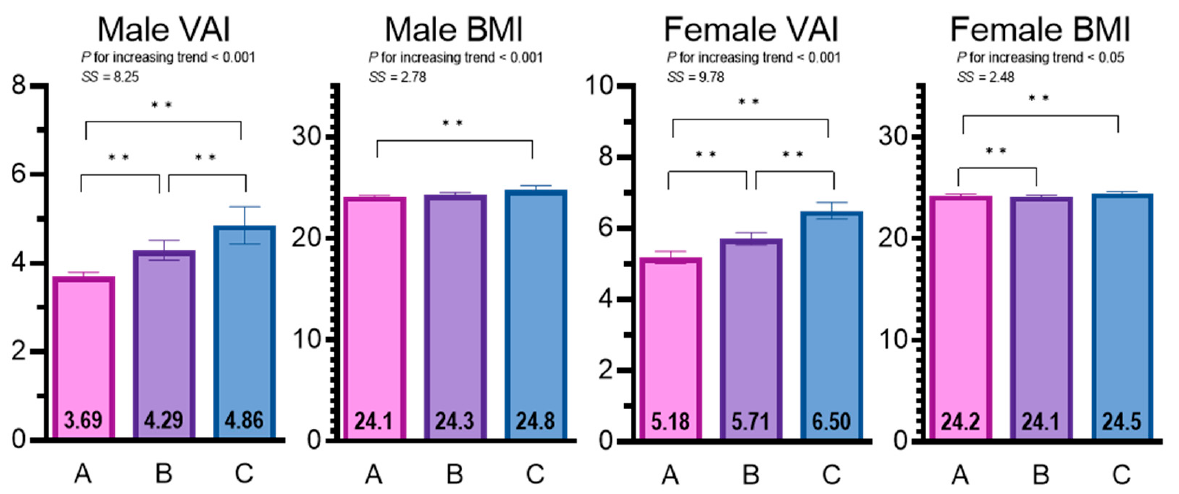
Figure 2. Sex-specific differences and trends in the VAI and BMI according to eGFR category. Values are mean ± 95 confidence interval. A = eGFR ≥ 60 (95% CI); B = eGFR 45–59.9 (95% CI); C = eGFR < 45; VAI = visceral adiposity index; BMI = body mass index; SS = standardized statistic. ** p < 0.01 for the difference between groups.